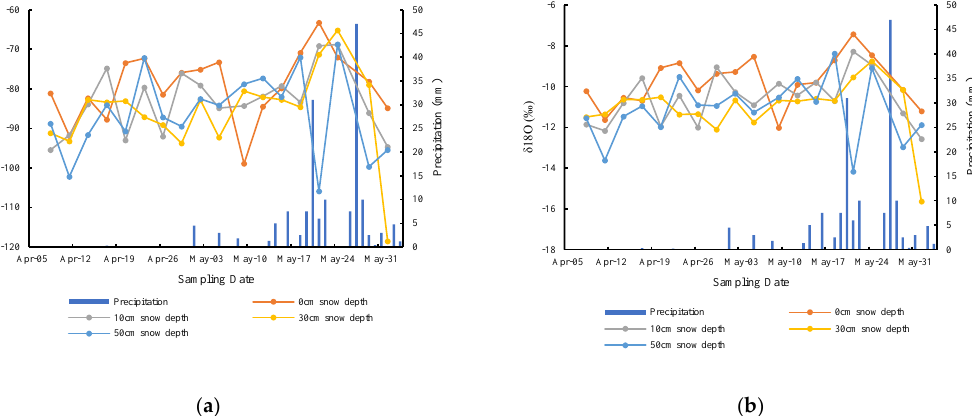
Figure 5. The change with time of δD and δ 18 O in soil water of different snow depth in 10 – 20 cm soil depth. ( a ) The change of δD ( b ) The change of δ 18 O.